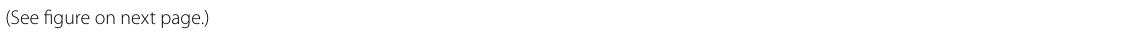
Protein extraction and Western